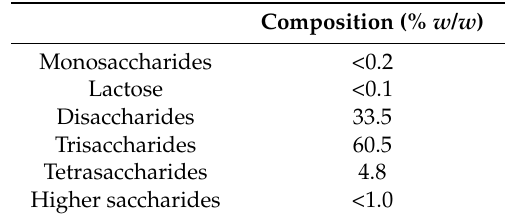
Table 1. Composition of the novel Lb-GOS mixture produced using β -galactosidase from Lactobacillus sp. after removal of monosaccharides and lactose.